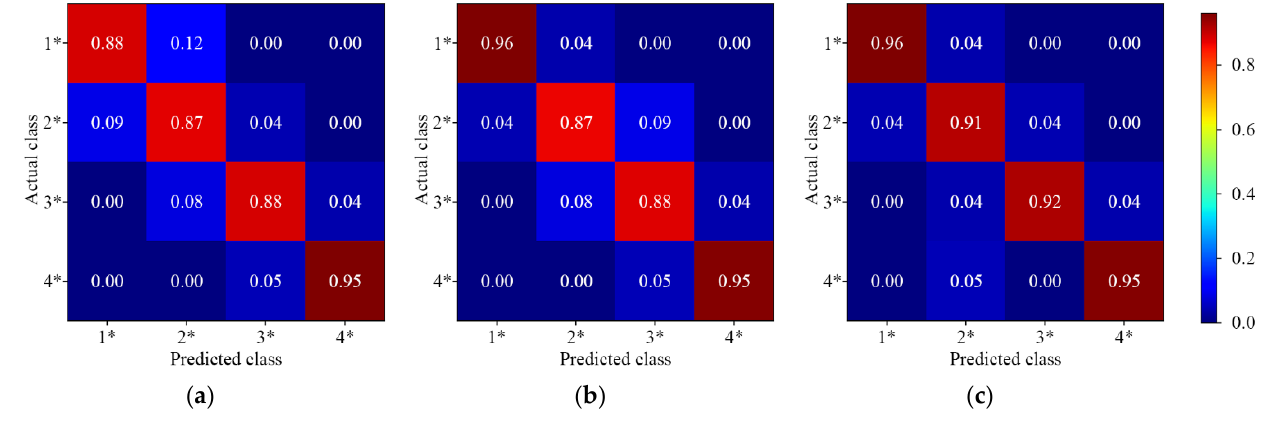
Figure 11. The normalized confusion matrix for four-level discrimination of beta-cypermethrin residues. ( a ) Single-depth 1D-CNN; ( b ) Symmetric multiscale 1D-CNN; ( c ) Asymmetric multiscale 1D-CNN.